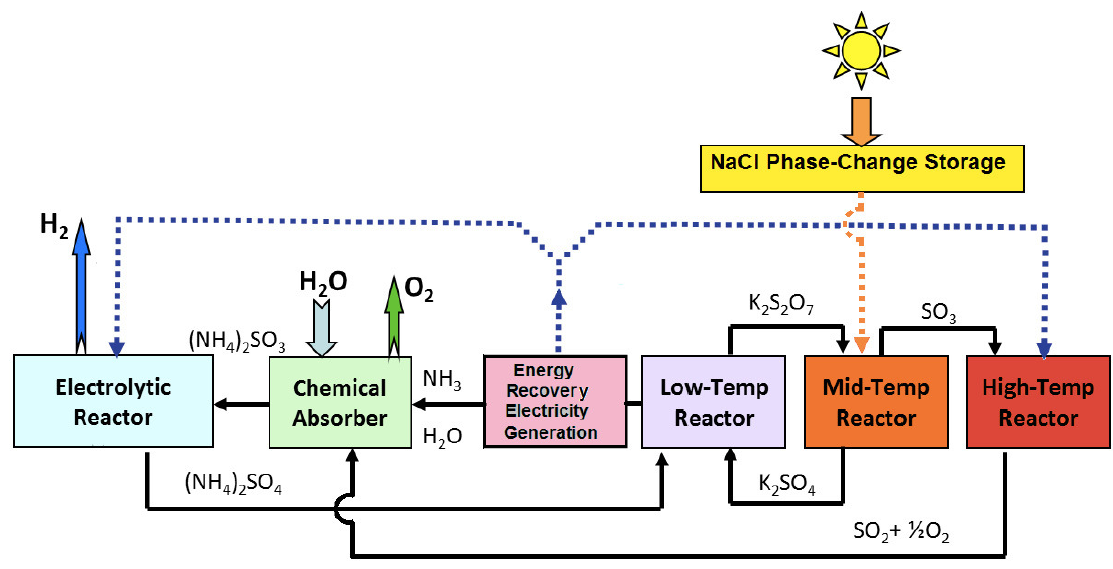
Figure 7. Schematic of an electrolytic sulfur-ammonia cycle [152].